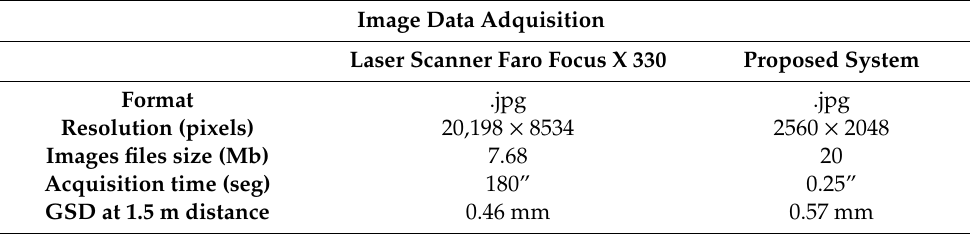
Table 7. Main characteristics of the images registered by both